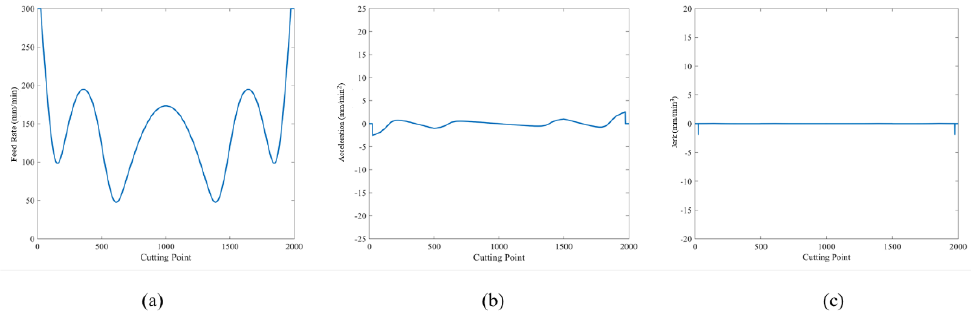
Figure 15. Cutting ∞ shape using method by Yeh and Hsu [10]: ( a ) feed rate, ( b ) acceleration, and ( c ) jerk.